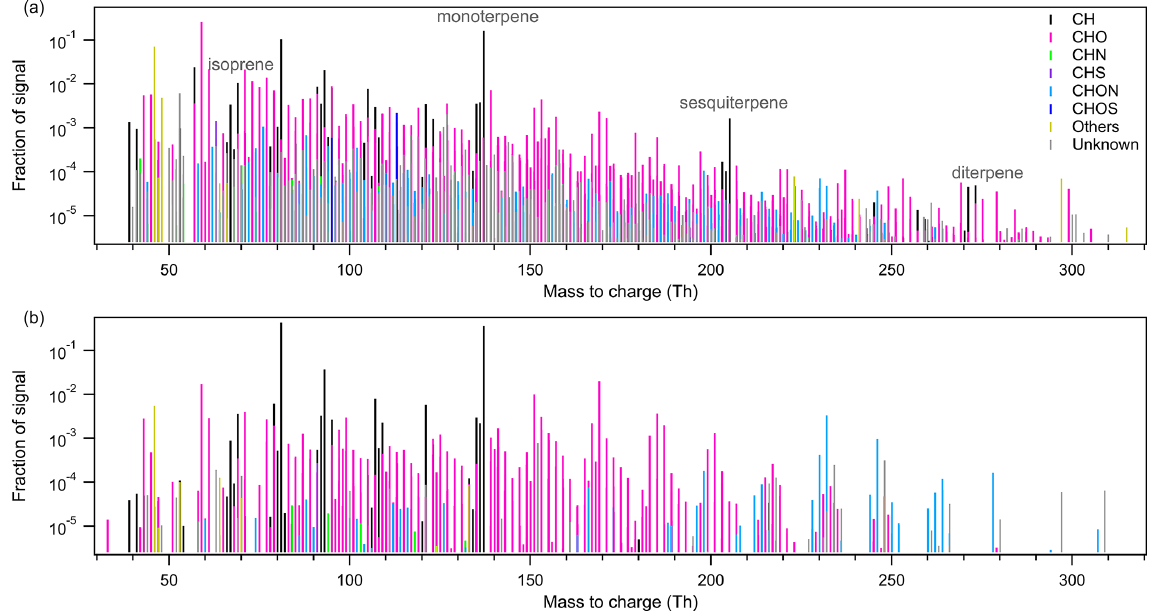
Figure 6. Comparison of ambient average high-resolution mass spectra with those from α -pinene oxidation experiments in the COALA chamber. (a) Ambient observations in the Landes forest; (b) α -pinene ozonolysis with NO x